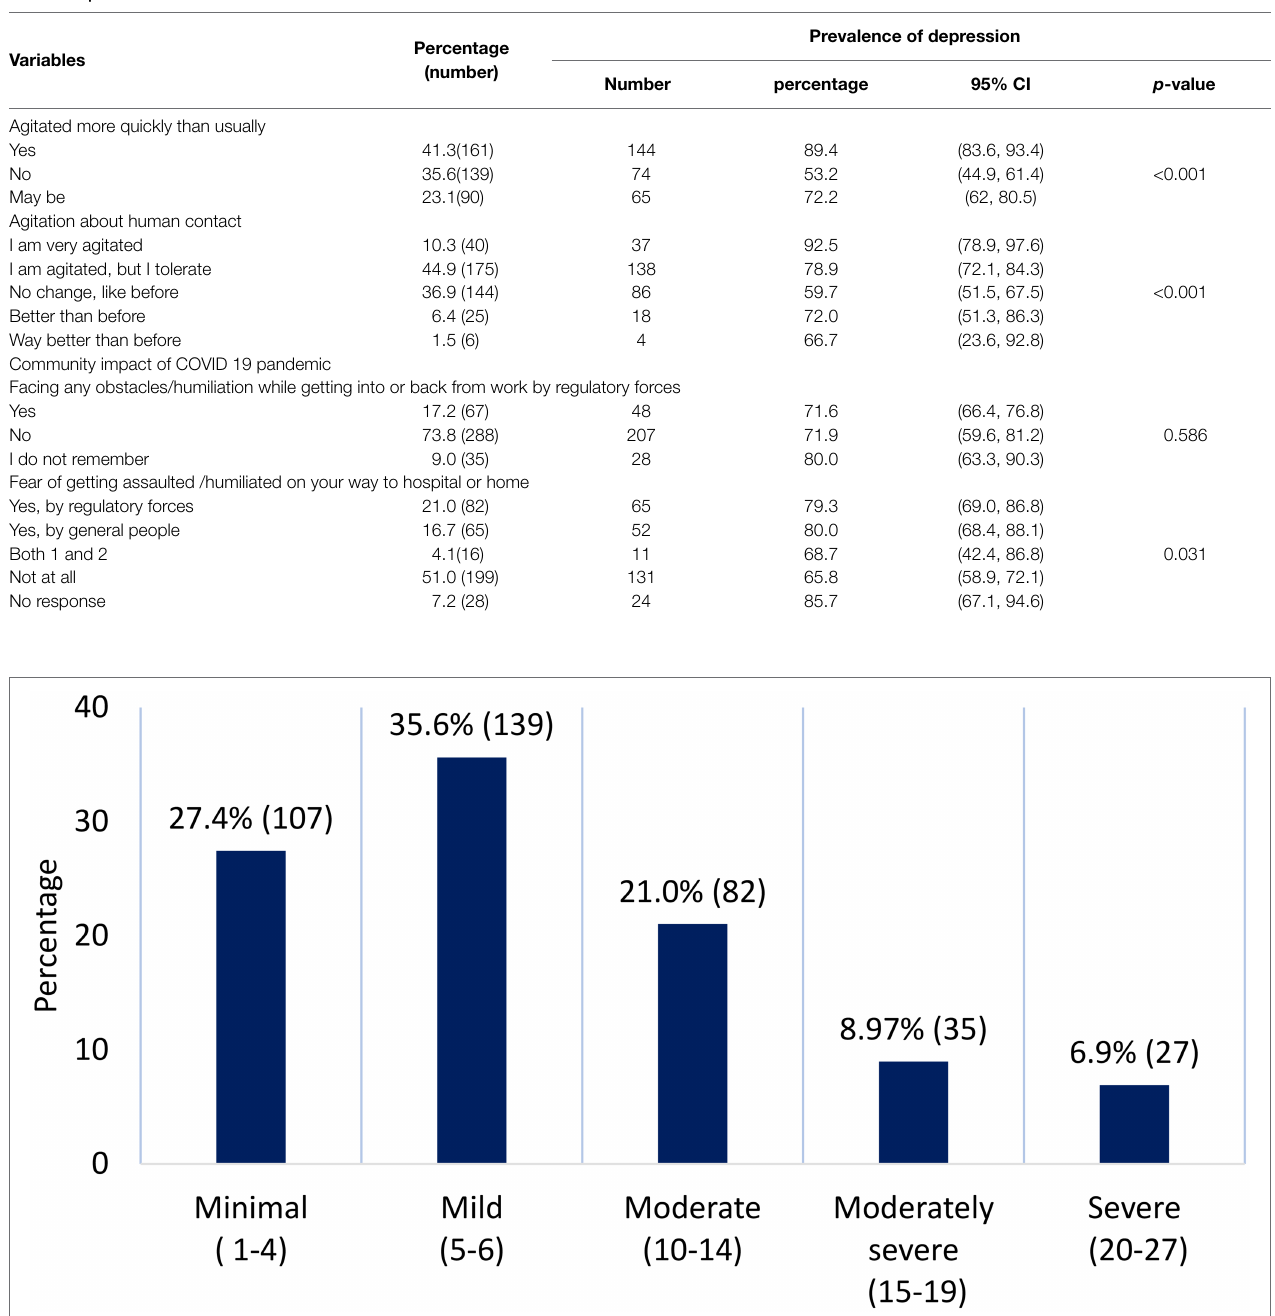
FIGURE 1 | Depression symptoms severity level during COVID-19 pandemic, measured using PHQ-9, was determined in 390